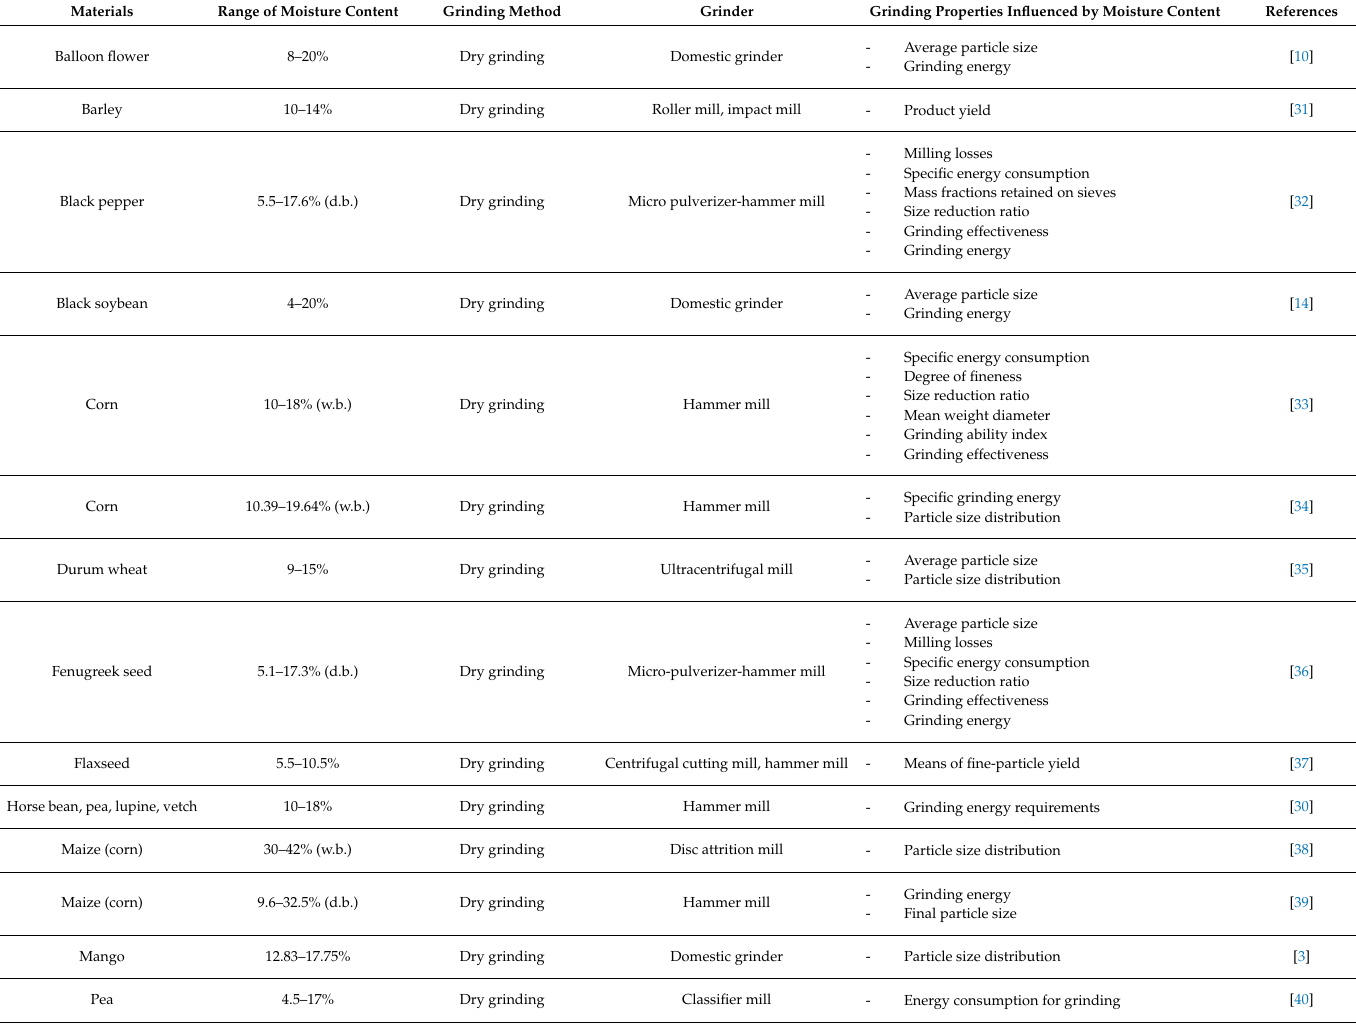
Table 1. Overview of research reports on the grinding of food materials with initial moisture